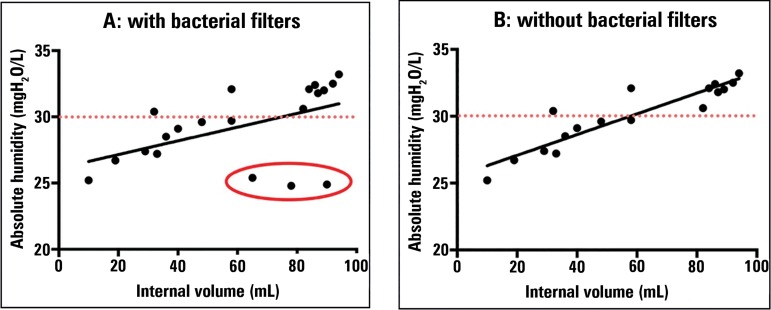
Correlation between the internal volume of the heat and moisture
exchanger and the absolute humidity delivered. The programming of
the ventilator corresponds to "Setting I" (tidal volume of 500mL,
respiratory frequency of 20 breaths per minute). In "B", the same
analysis as in "A" was conducted, but excluding the 3 bacterial
filters (Pall, Intertech HEPA, Intersurgical). Pearson's correlation
coefficient was used for the statistical analysis.